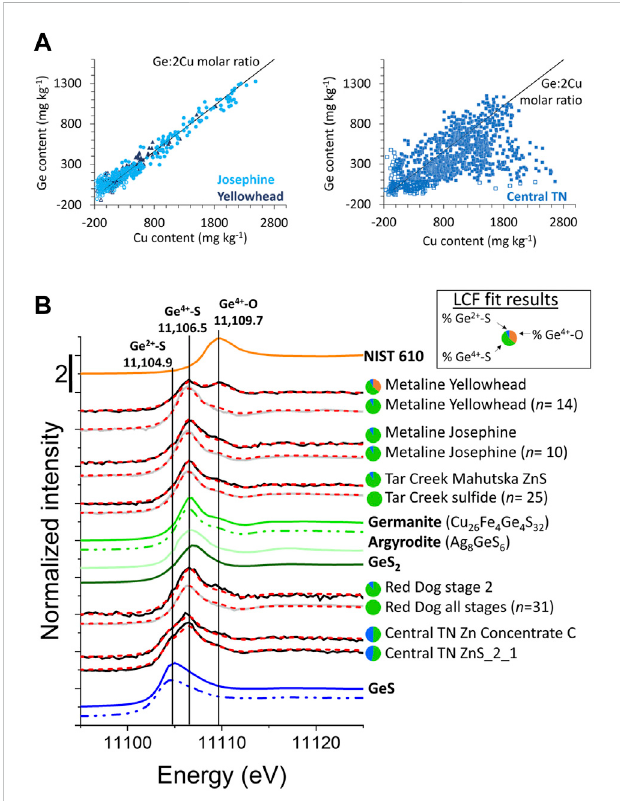
FIGURE 6 Selected electron microprobe data, and bulk and micro-focused Ge XANES spectra. (A) Microprobe data from Metaline and Central Tennessee districts. Analyses from Metaline demonstrate a strong correlation between Cu and Ge along the Ge:2Cu molar line, whereastheCentralTennesseeanalysesindicatealessclearrelationship between Cu and Ge. Open symbols indicate data that are below detection limit for at least one element. (B) Germanium micro-focused and bulk XANES spectra. Micro-focused spectra are shown in gray with the number of merged scans ( n ) indicated in the label, while bulk XANES are shown in black. Linear combination fi ts using NIST 610, germanite, and GeS references are plotted in red dashed lines with results in the pie charts. Reference spectra are plotted in color with solid lines representing bulk measurements and dash-dot-dot indicating micro- focused